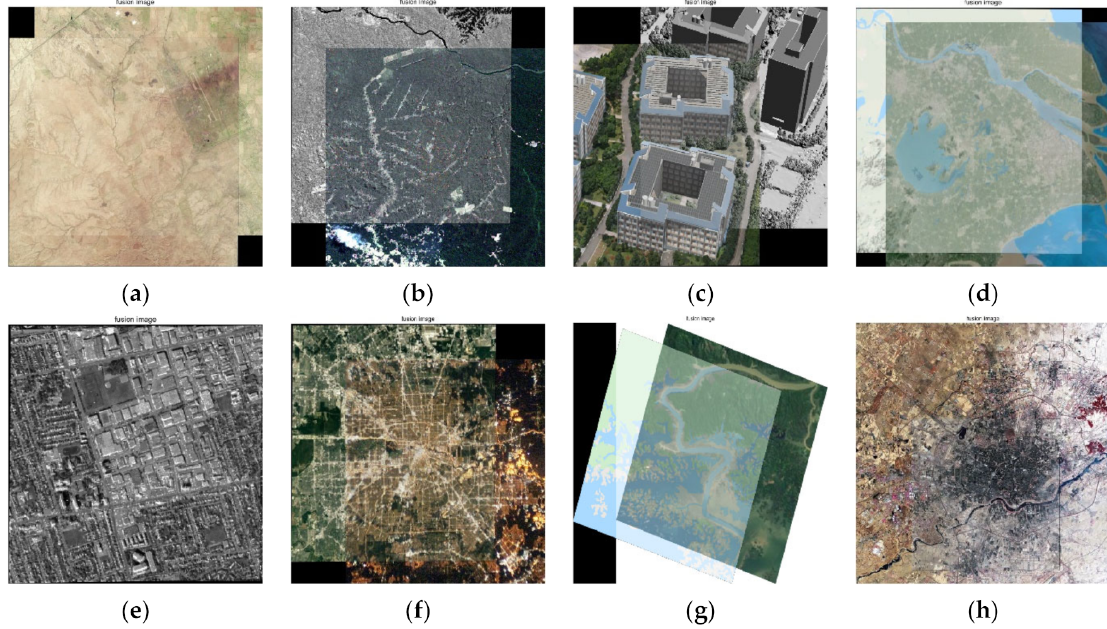
Figure 13. Fusion effect of image pairs: ( a ) optical–optical; ( b ) optical–infrared; ( c ) optical–depth; ( d ) optical–map; ( e ) optical–SAR; ( f ) day–night; ( g ) rotation; ( h ) scale.